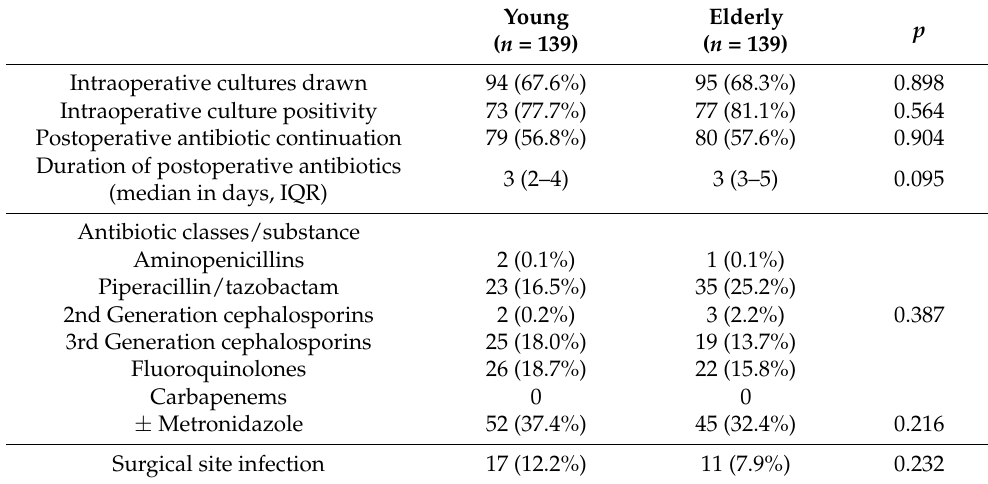
Table 2. Infectious disease